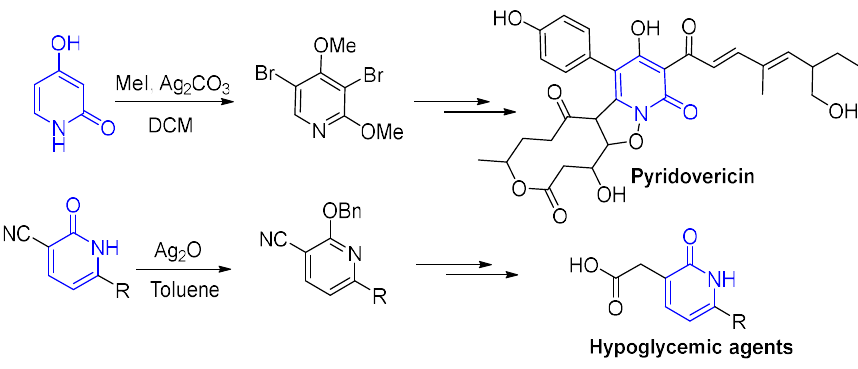
Scheme 1. The synthetic routes of pyridomacrolidin and hypoglycemic